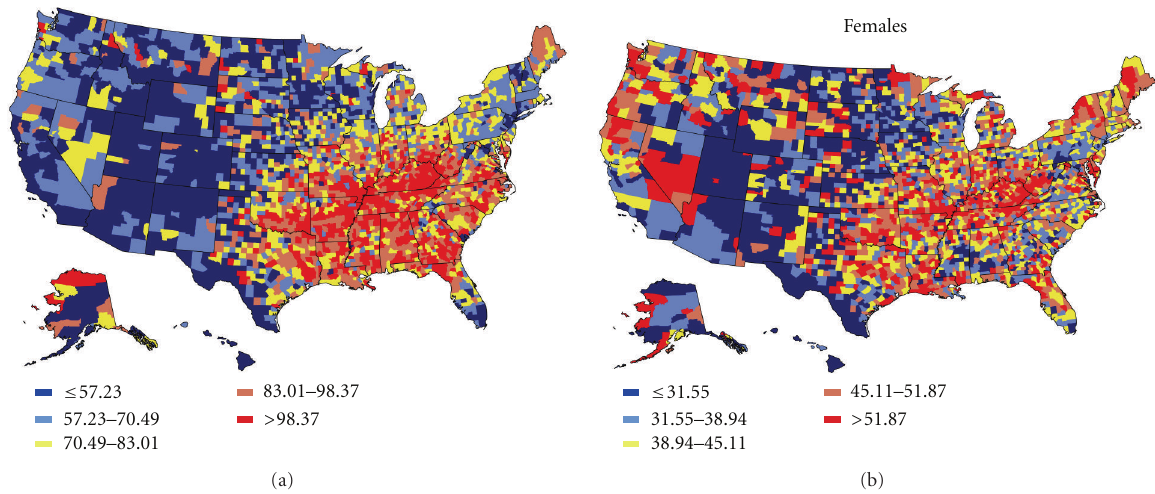
Figure 3: Lung cancer mortality rates per 100,000 population (age adjusted to the 2000 population), US males and females, 2003–2007 (3,141